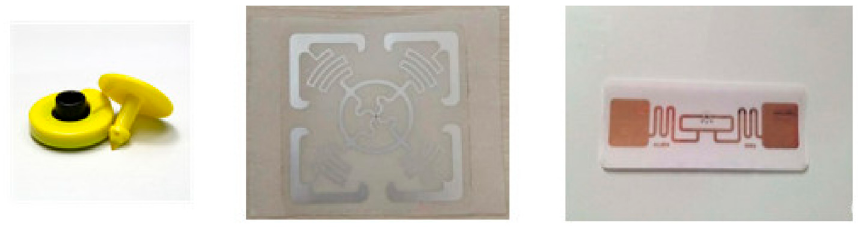
Figure 17. The UHF RFID tag.